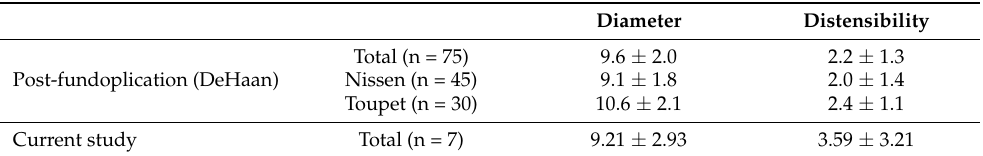
Table 5. Diameter and distensibility parameters (mm 2 /mmHg) in the current study compared to those found by DeHaan et al.